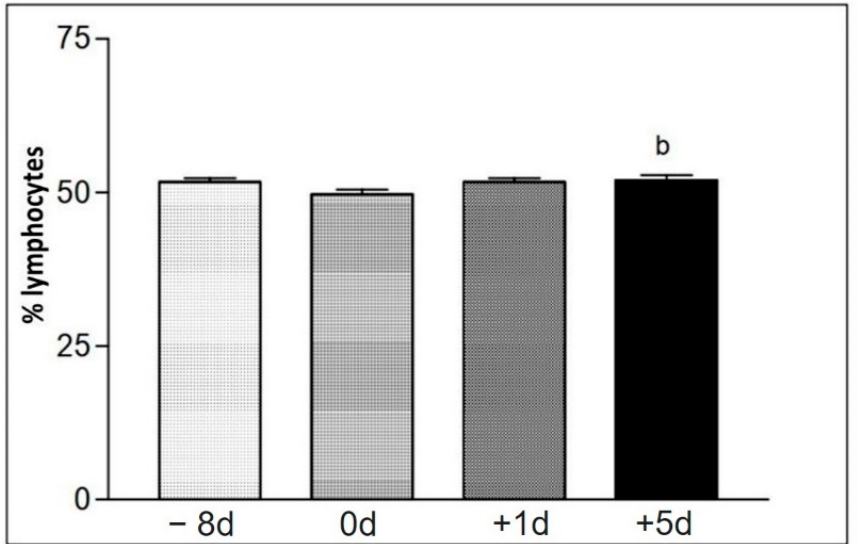
Figure 8. Representation of the average values of the relative number (%) of lymphocytes (Lo) on the different collection days defined as − 8 d, 0 d, +1 d, and +5 d. Statistical difference performed according to the Tukey–Kramer test—Beltsville, 2003. b = significant statics difference.